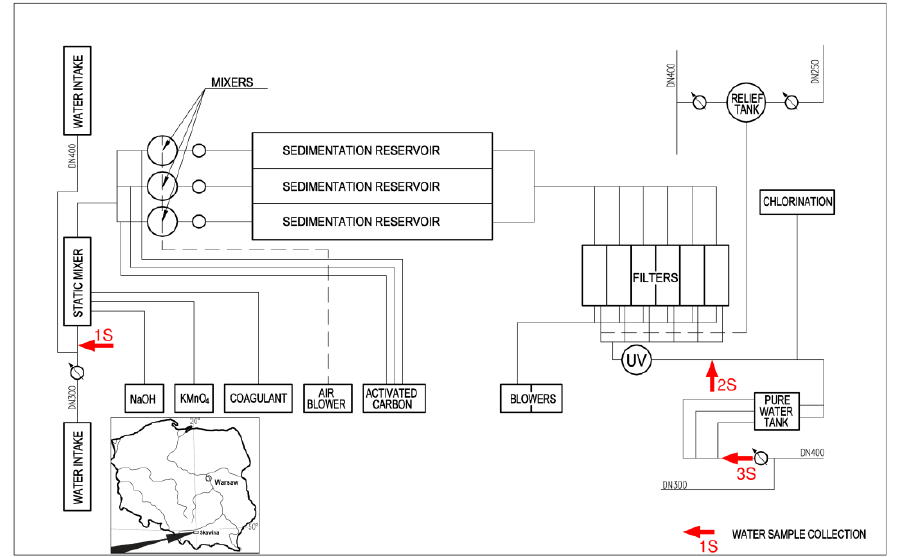
Figure 1. Water treatment line at WTP Skawina.